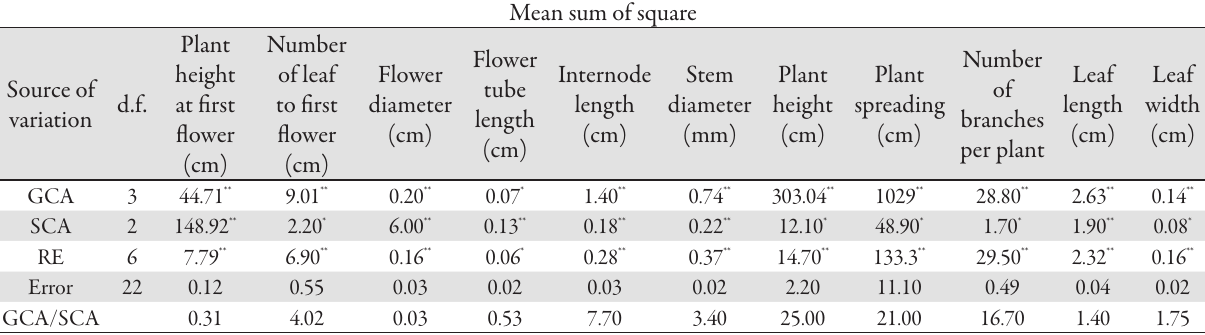
Tab. 2. Analysis of variance for combining ability of plant height at first flower, number of leaf to first flower, flower diameter, flower tube length, internode length, stem diameter, plant height, plant spreading, number of branches per plant, leaf length and width in hybrids and their parents of petunia